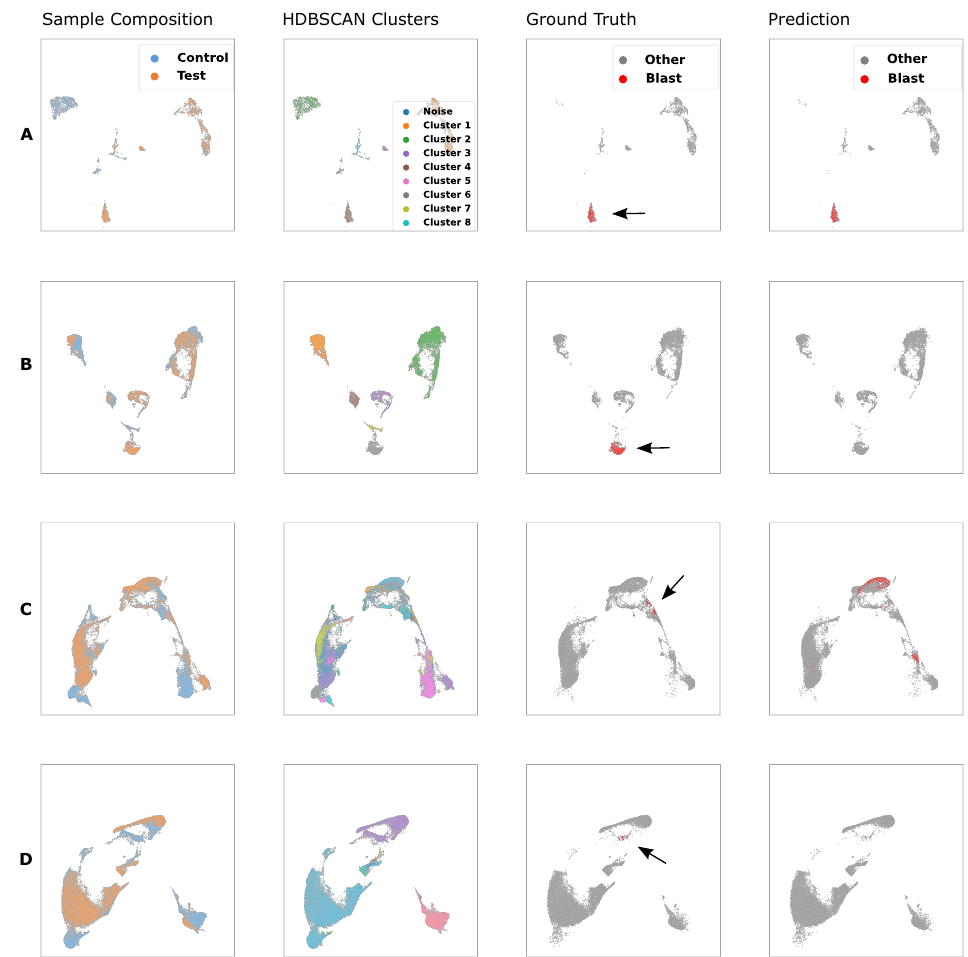
Figure 6. Each row corresponds to one FCM sample that is analysed. The first column shows the composition of test- and control-events, the second the clusters detected by HDBSCAN (each color defines one cluster), the third column shows the embedding of the test sample only and the blasts found by manual gating (arrowheads point at blasts) and finally, the last column the detected blasts by the method proposed, while sample ( A ) is a prime example, where blasts form a separate cluster that is correctly detected, ( B – D ) are examples for the issues identified. ( B ) shows a sample, where blasts form a separated cluster, yet it was not detected as the percentage of control-events in this cluster was a bit above the 5% threshold. ( C ) is an example for false positive clusters. The blast cluster was correctly identified but others as well due to poor coverage of healthy cells and a finer HDBSCAN clustering. Finally, ( D ) is a sample where blasts are not well separated in the embedding space due to missing drop-in markers and hence blasts are not detected as single